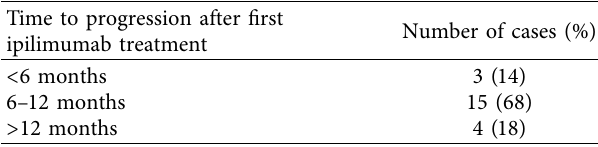
Table 3: PFS between challenge and rechallenge.